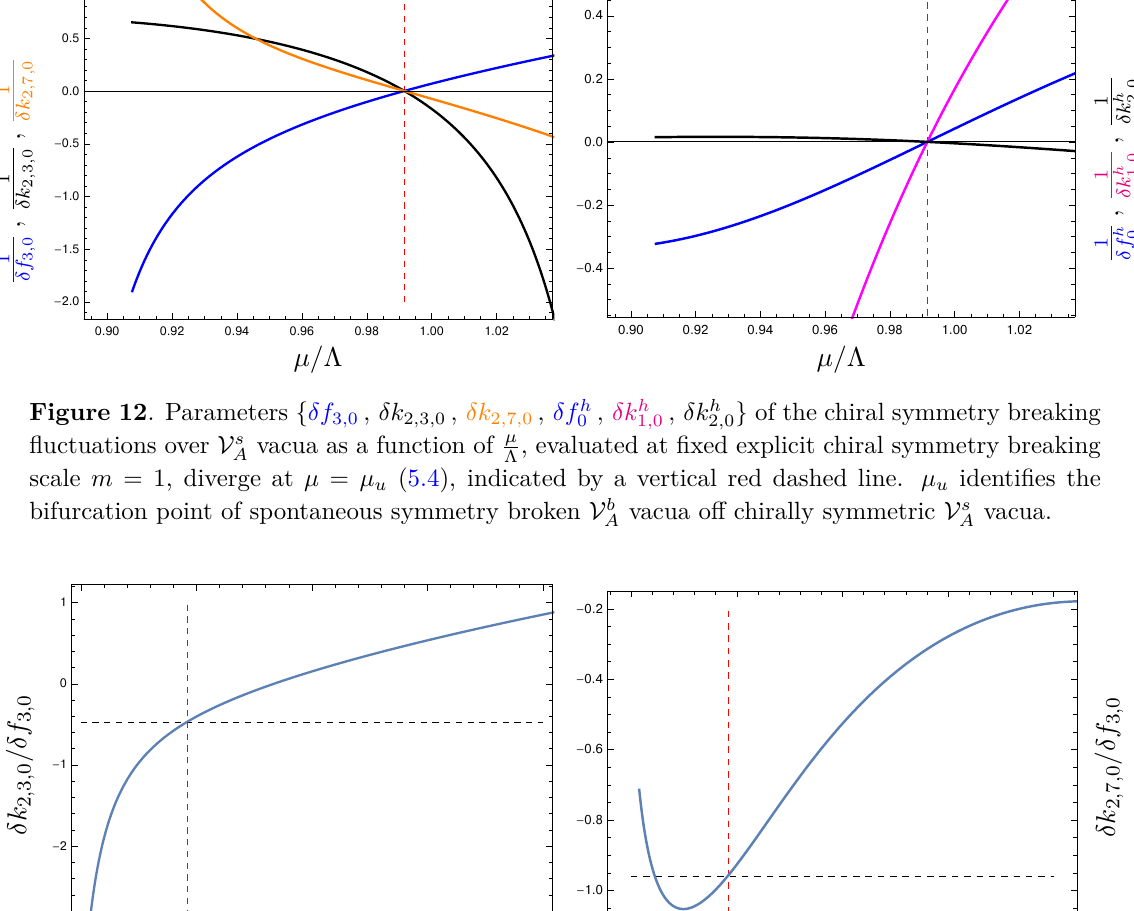
Figure 13 . Susceptibilities of the UV parameters, see (5.35), of the linearized chiral symmetry breaking fluctuations. The red dashed vertical line denotes µ u , see (5.4). The black horizontal dashed lines indicate the values of the susceptibilities at µ = µ unstalble , see